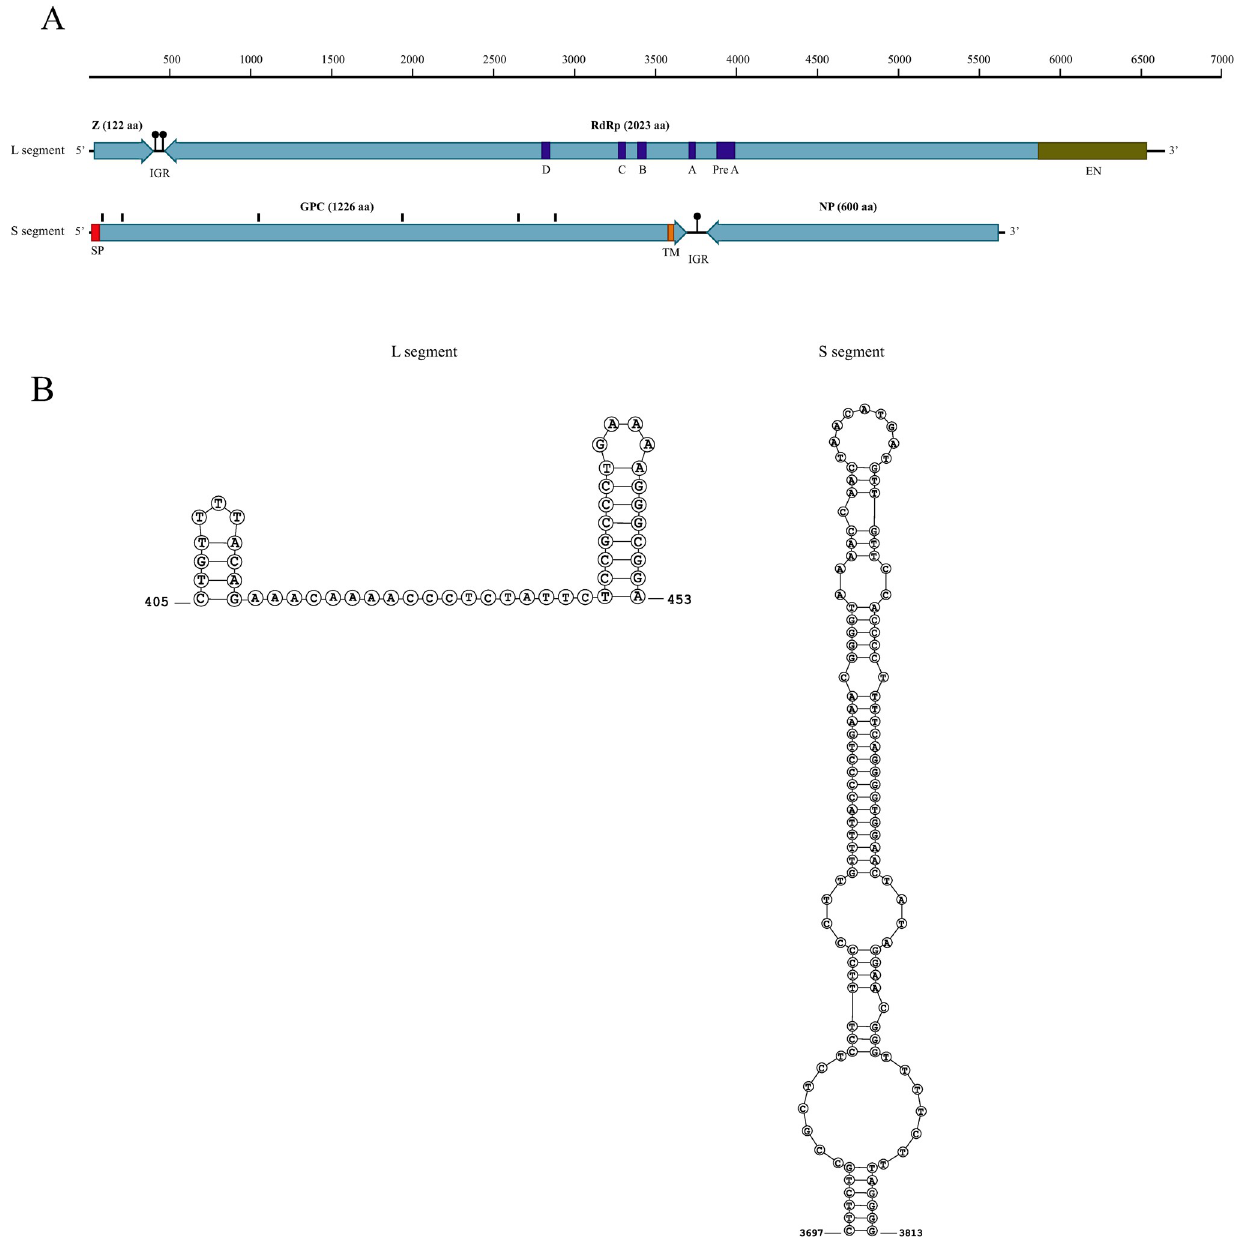
Fig 9. Genomic characterization of the 2020 isolate of Turtle fraservirus 1 (TFV1). (A) Schematic representation of the TFV1 genome. Open reading frames (ORFs) are shown as light blue boxes, the endonuclease domain in the RNA-dependent RNA polymerase is indicated by an olive green box and the conserved motifs are indicated by dark blue boxes. The glycosylation sites in the glycoprotein precursor polyprotein are marked by black lines above the ORF, the signal peptide is indicated by a red box and the transmembrane domain is indicated by an orange box. Abbreviations: Z, zinc-finger protein; RdRP, RNA-dependent RNA polymerase; GPC, glycoprotein precursor polyprotein; N, nucleoprotein; IGR, non-coding intergenic region; EN, endonuclease; Pre A, premotif A; A, motif A; B, motif B; C, motif C; D, motif D; SP, signal peptide; TM, transmembrane domain. (B) Predicted stem-loop structures within the non-coding intergenic regions in L and S